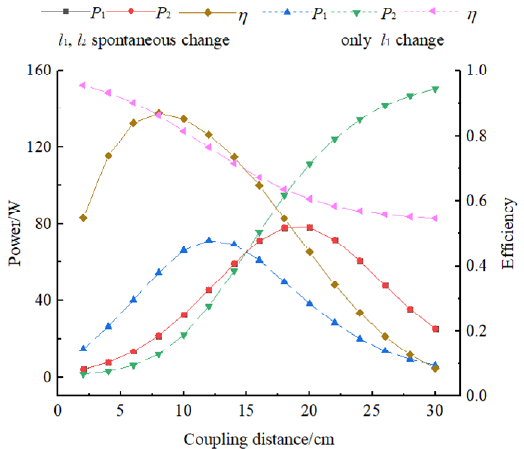
Figure 6. The relationship between the coupling distance on the different sides of the coaxial and the system parameters.